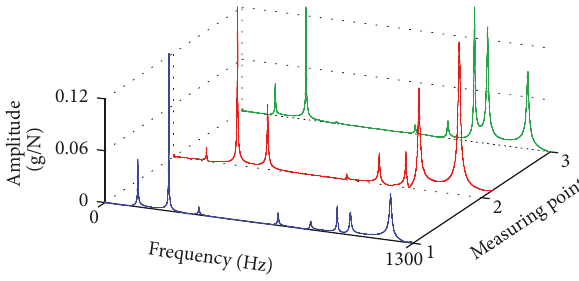
Figure 5: Frequency response functions of composite thin plate obtained at three different measuring